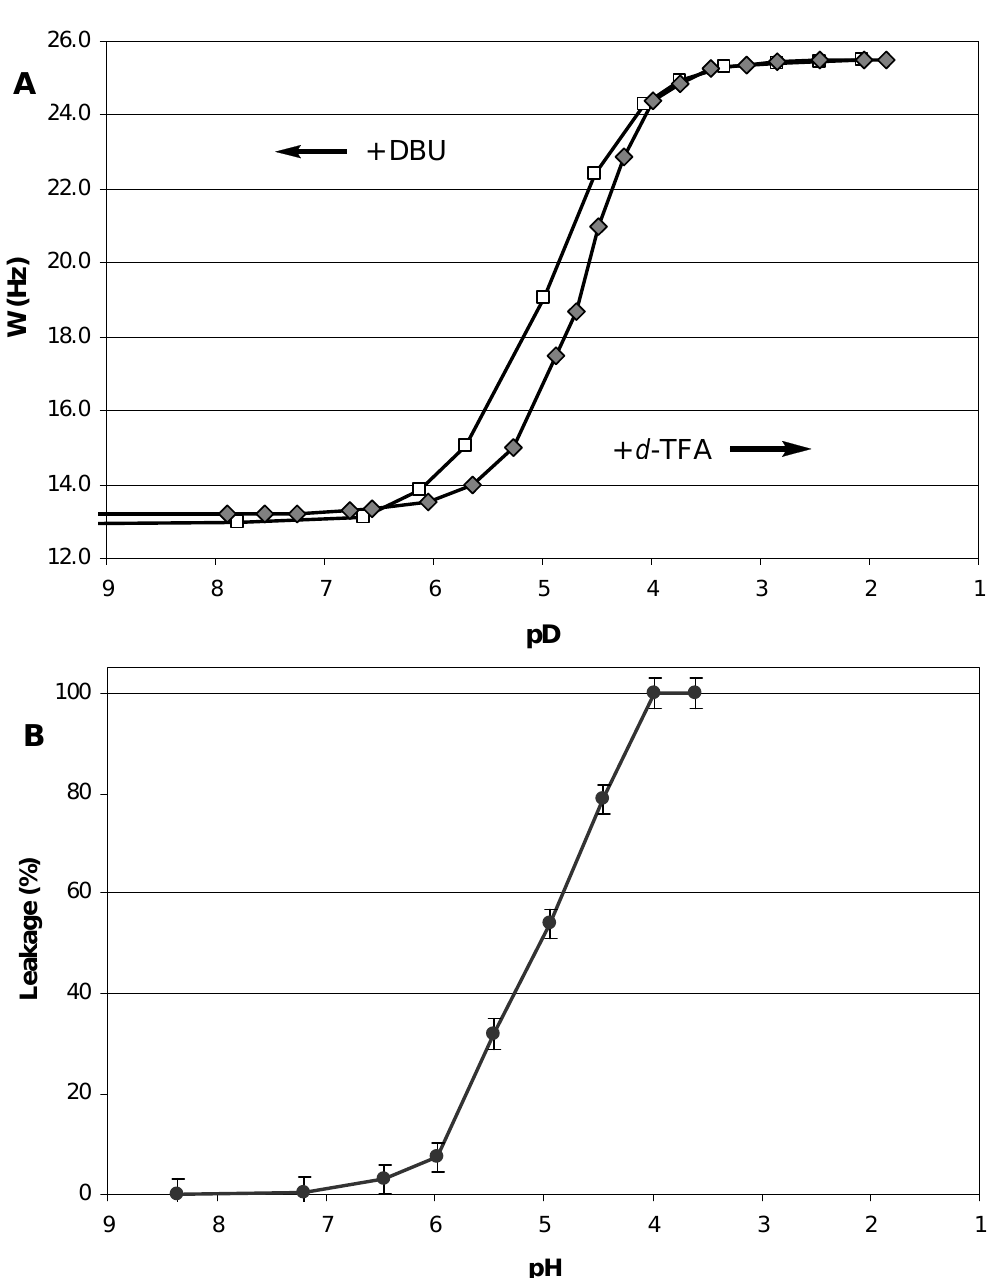
Figure 2. (A) Change of the signal width (W =  J the conformational switch of flipid 1 in CD and then by backward titration of the resulting acidic solution with DBU ( □ ).